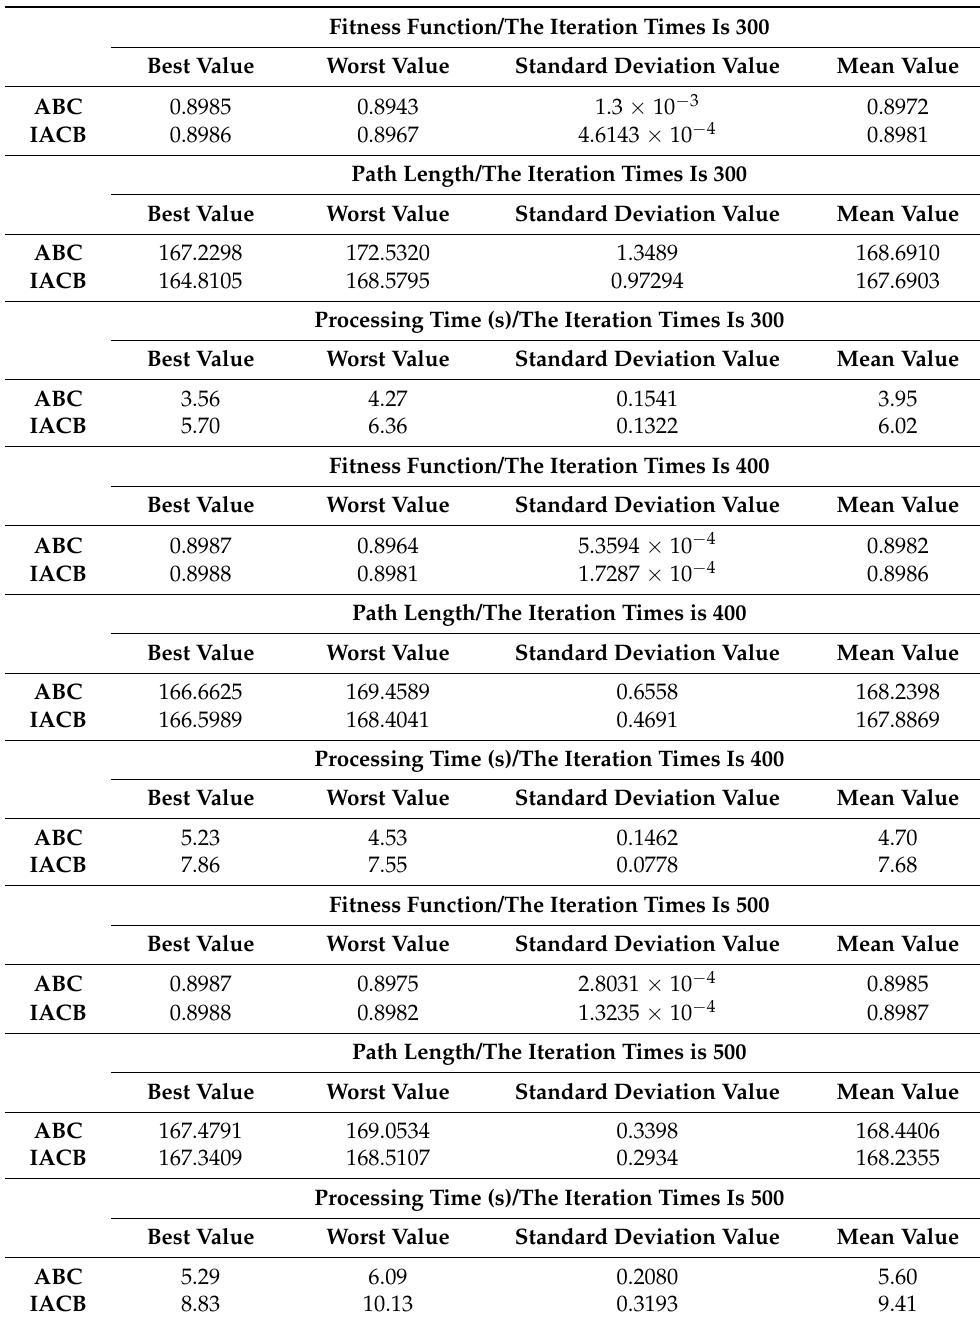
Table 9. Performance evaluation results of ABC and IABC using different iteration